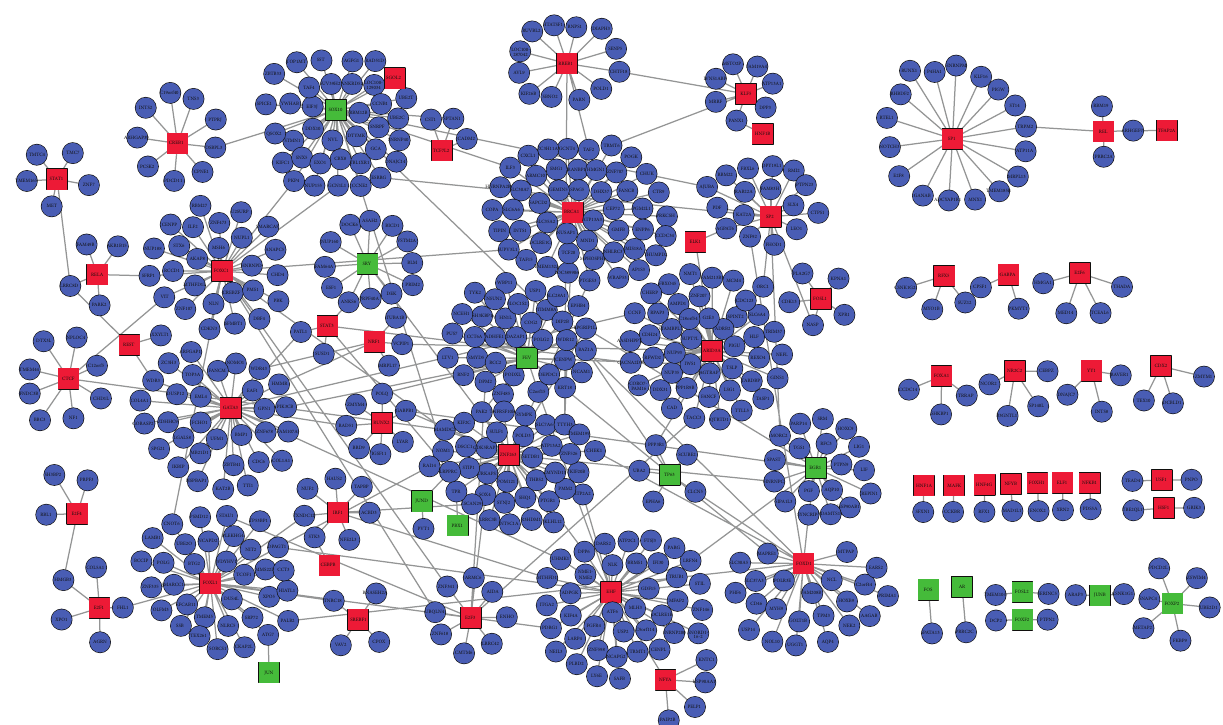
Figure 1: The established transcriptional regulatory network in gastric cancer. Rectangle indicates TFs, and ellipse indicates target genes. Red-color and green-color nodes represent products of upregulated and downregulated TFs, respectively. Blue nodes indicate differentially expressed target genes.